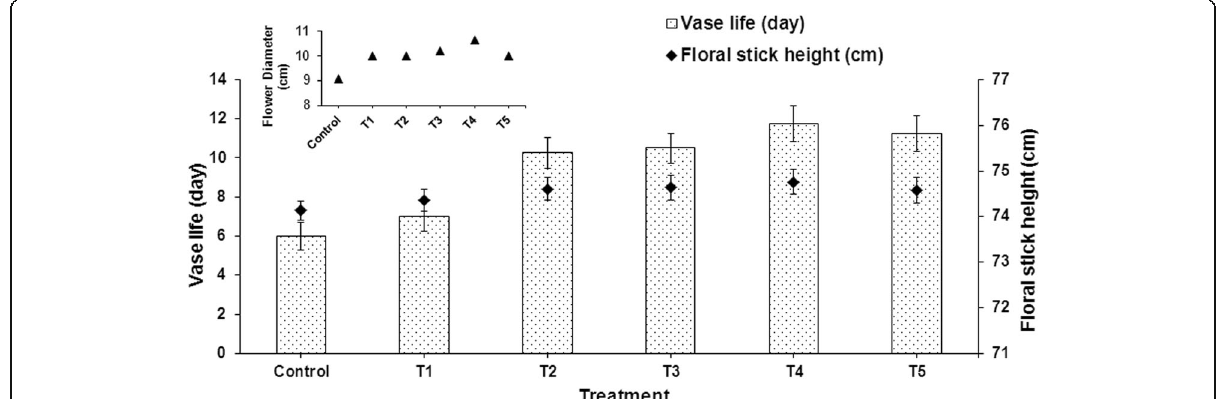
Fig. 2 Effect of different vase solutions (control, T 1 , T 2 , T 3 , T 4, and T 5 ) in vase life (day) and floral stick height (cm) of gladiolus cut spikes. Inset represents the average flower diameter of differently treated gladiolus cut spikes during vase life. Vertical bars show ± SE of mean